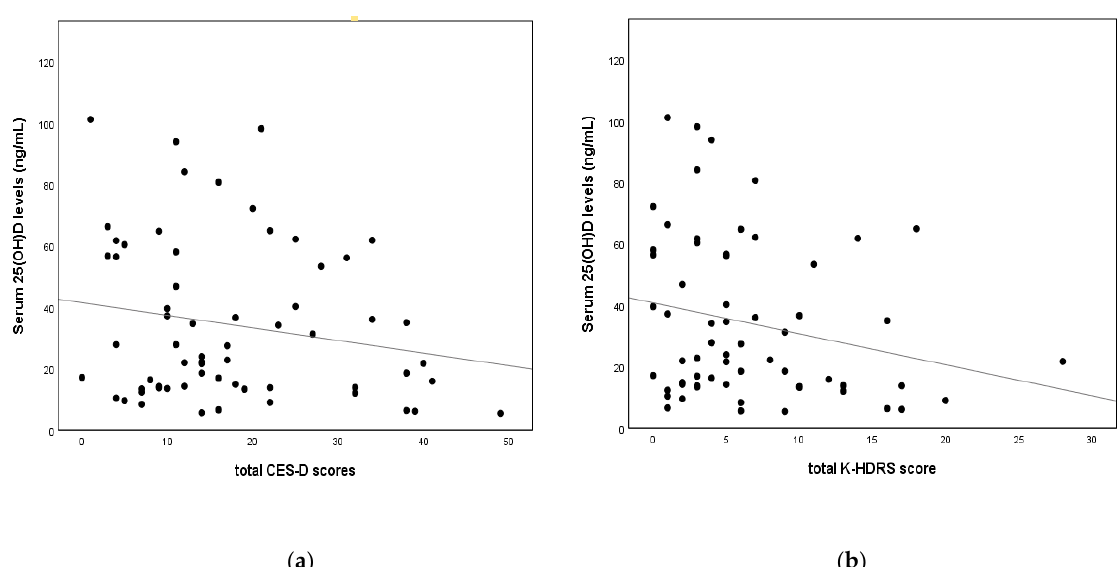
Figure 2. Correlation between depression severity and serum 25-hydroxyvitamin D levels after adjusting for age and body mass index. ( a ) Serum 25(OH)D levels and total CES-D score ( r = − 0.127, p = 0.330); ( b ) serum 25(OH)D levels and total K-HDRS score ( r = − 0.256, p = 0.045). Abbreviations: CES-D—Center for Epidemiological Studies–Depression Rating Scale, K-HDRS—Korean version of the Hamilton Depression Rating Scale, 25(OH)D—25-hydroxyvitamin D.